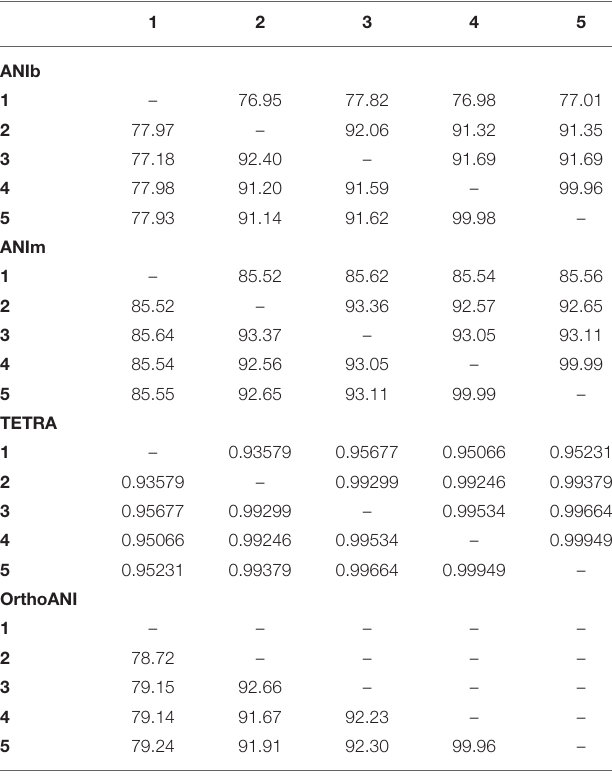
Strains: 1, Streptomyces palmae CMU-AB204 T ; 2, Streptomyces catenulae NRRL B- 2342 T ;3,StreptomycesramulosusNRRLB-2714 T ;4,MZ03-37 T ;5,MZ03-48.–,Means that pairwise genome comparison against themselves result in 100% identity.